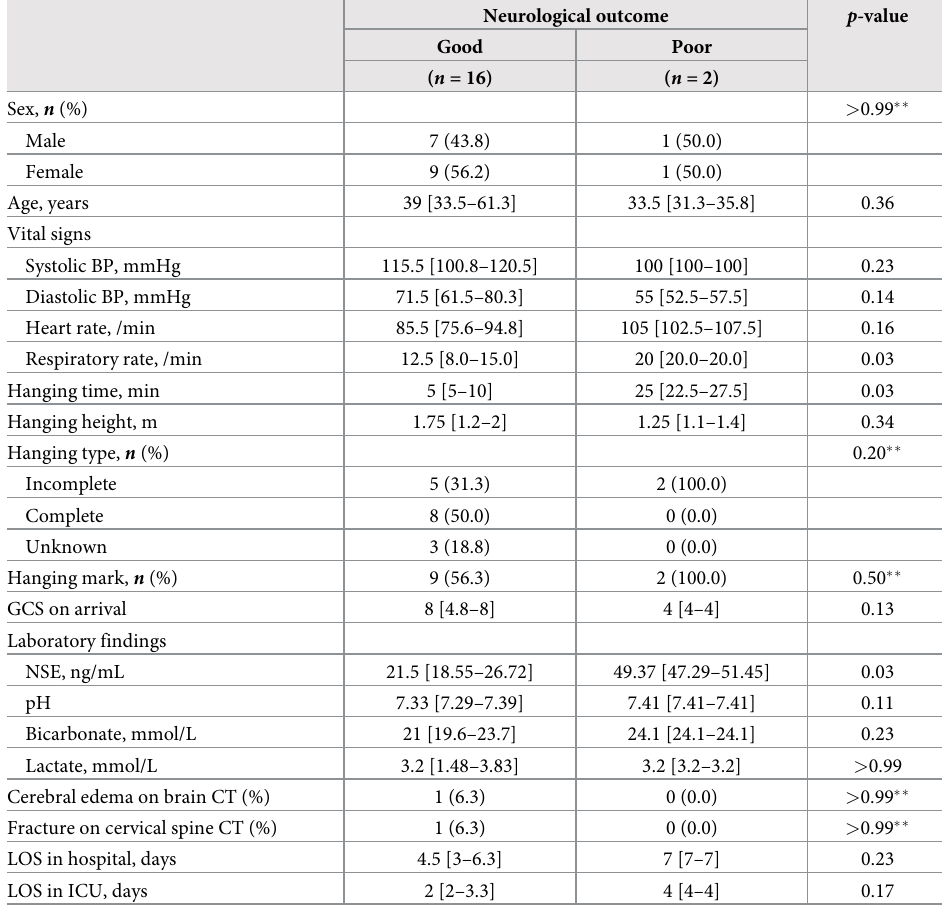
Table 2. Comparison between the good and poor neurological outcome near-hanging patients without cardiac arrest.